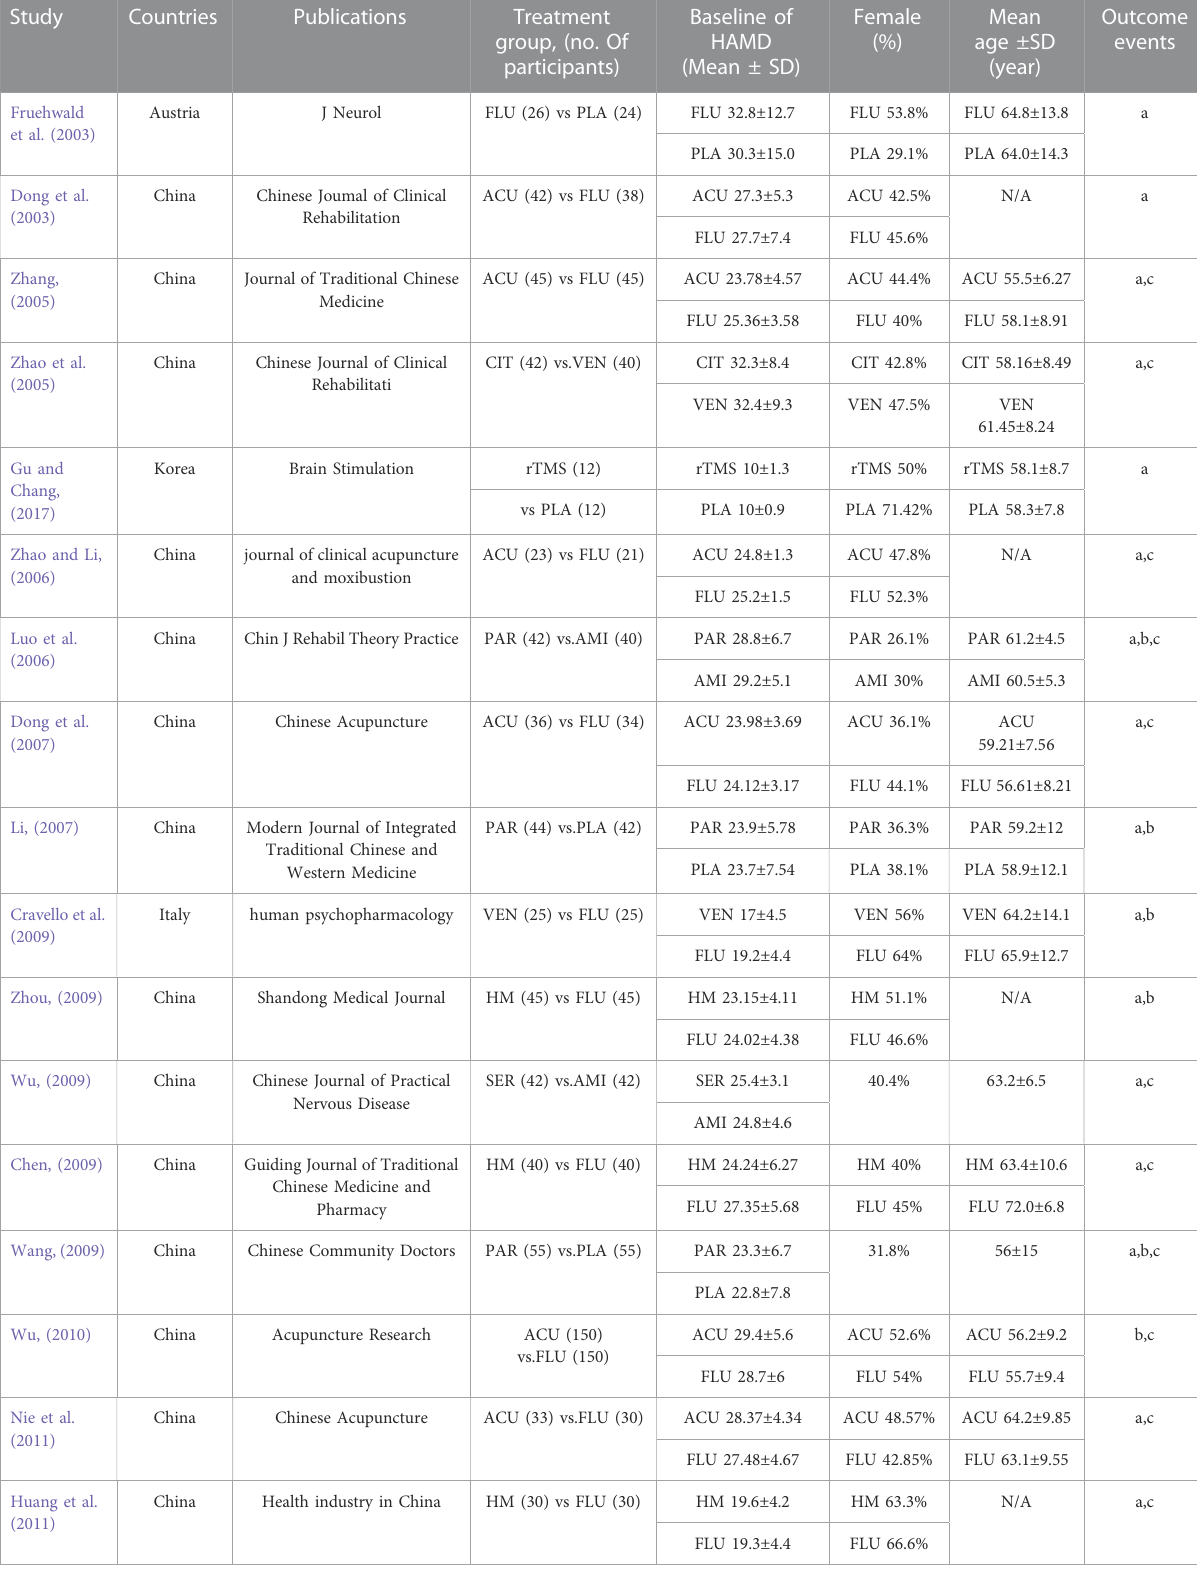
TABLE 1 Characteristics of the included studies and outcome